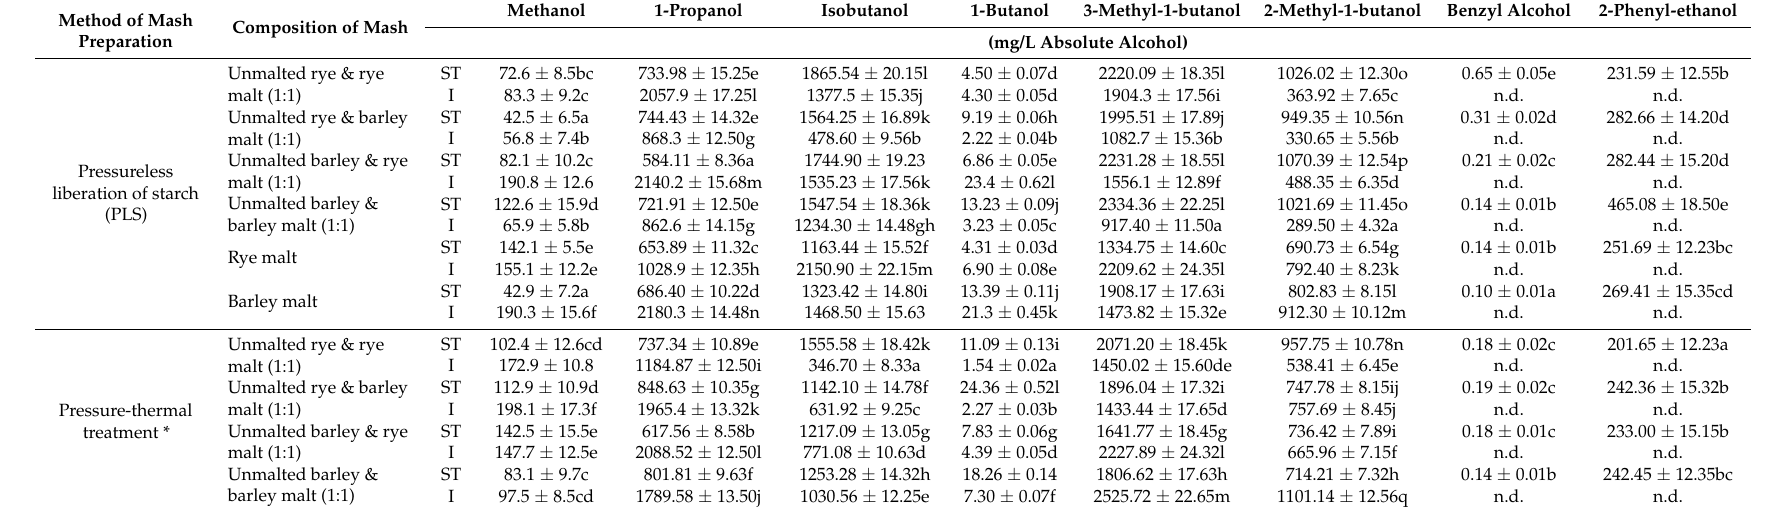
Table 5. Concentrations of methanol and higher alcohols in the obtained agricultural